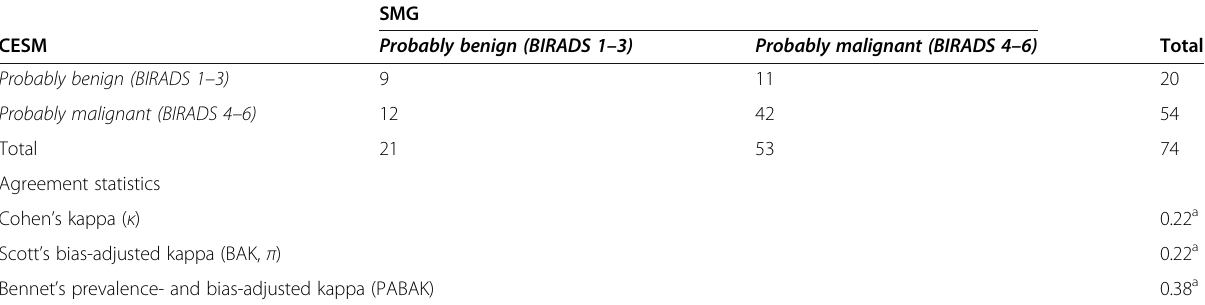
Table 15 Agreement between SMG and CESM regarding lesion classification as probably malignant or probably benign in patients with ACR C/D SMG